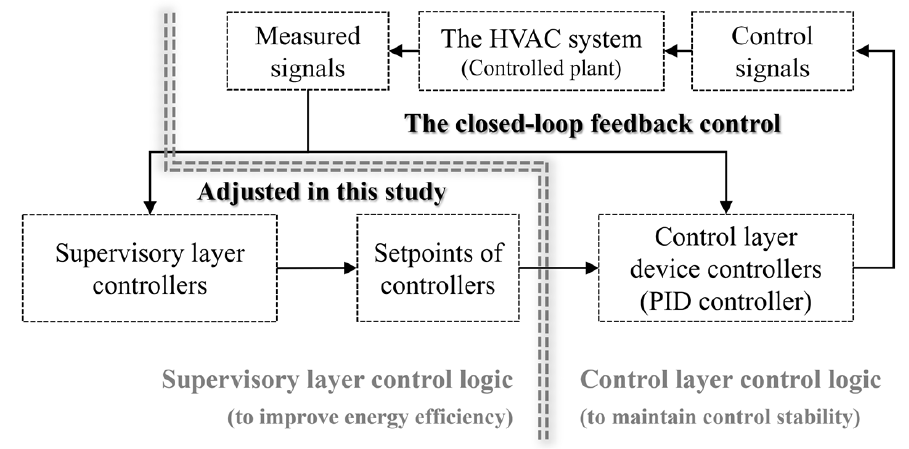
Figure 2. Diagram of the control structure.